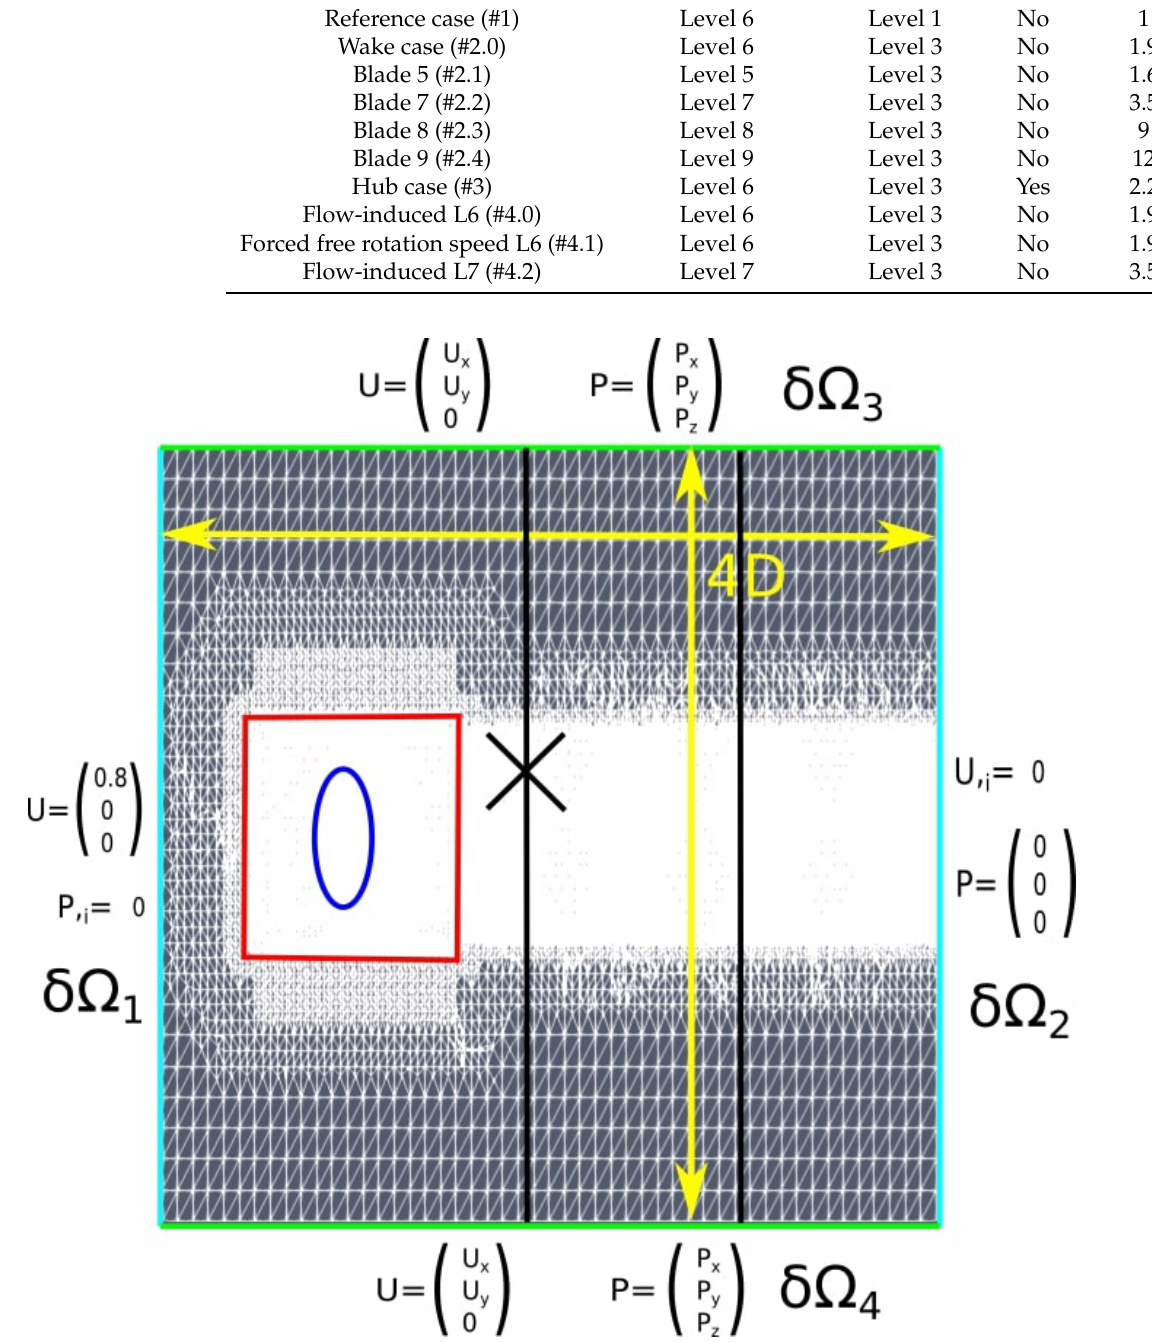
Figure 8. View of the X–Y plane of the computational domain with boundary conditions. D is the rotor diameter. U is the flow velocity in m · s − 1 , P is the pressure in Pa, and P local is the pressure at the calculated point closest to the wall. The red square delimits the arbitary mesh interface (AMI) zone, and the blue circle shows the rotor position. The two black lines (1.2D and 2D) and the black cross are the extraction lines and the probe, respectively, used in the model validation in Section